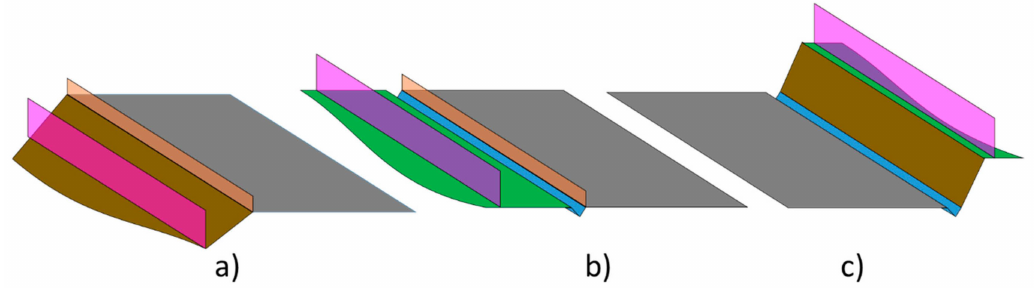
Figure 1. Typical configurations of elements the road environment: ( a ) road at a greater height than the environment, ( b ) road at the same height as the environment, ( c ) road at a lesser height than the environment. Color code: road surface in dark grey, ditch in blue, embankments in brown, border in green, guardrail in orange and fences in